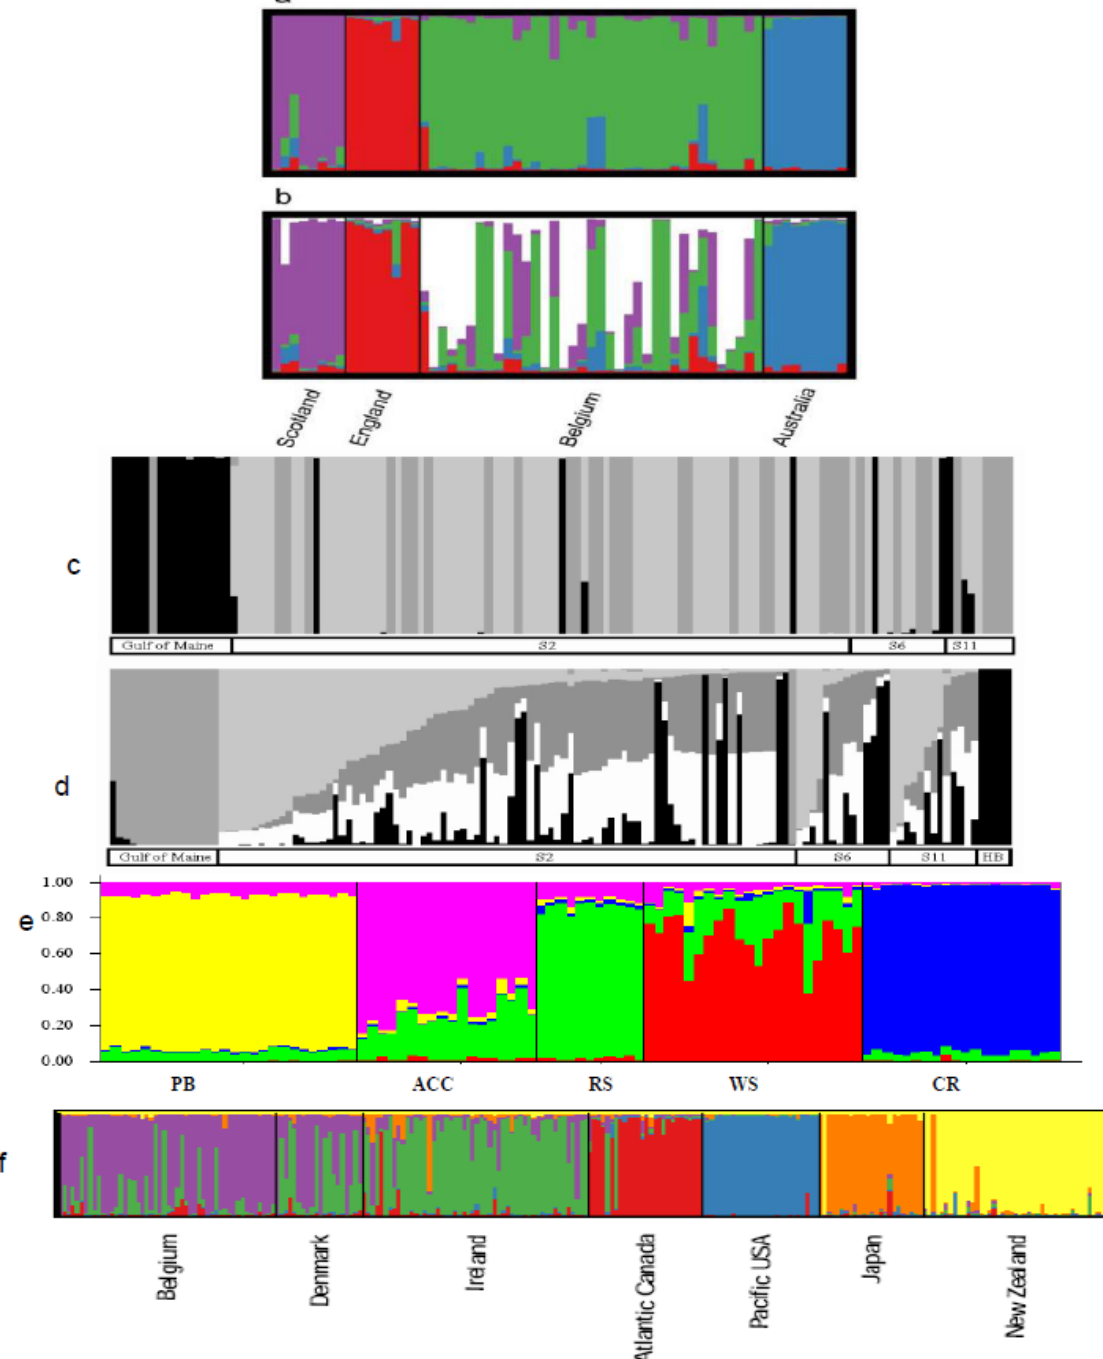
Figure 4. Comparison of population structure as determined by STRUCTURE of Sellaphora capitata over four geographical areas assuming (a) four populations and (b) five populations [139, reproduced courtesy of Elsevier], of Alexandrium tamarense as shown by MS (c) and AFLPs (d) analyses from the western north Atlantic (Gulf of Maine), eastern North Atlantic (S1,S6,S11), and western Pacific isolates (HB) [87 Alpermann, 2009], (e) of Pseudo-nitzschia pungens [147, reproduced courtesy of PNAS], and (f) of Phaeocystis antarctica from major gyres around the Antarctic (PB = Prydz Bay, ACC = Antarctic Circumpolar Current, RS = Amundsen Sea/Ross Sea, WS = Weddell Sea/Scotia Sea, CR = Coastal Region)